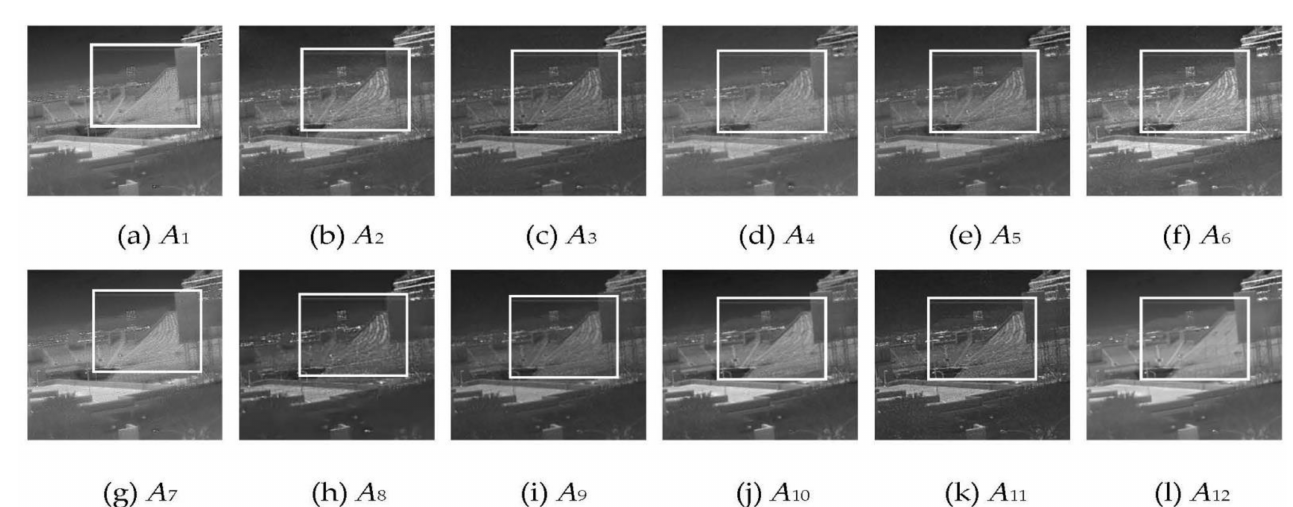
Figure 9. Two groups of verified images.